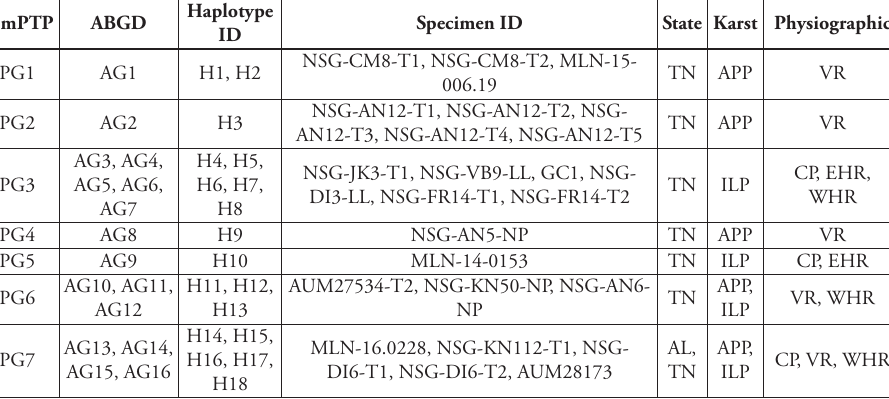
Table 3. Species delimitation results from both ABGD and mPTP analyses. Haplotype diversity, speci- men ID, state, karst region, and physiographic province also